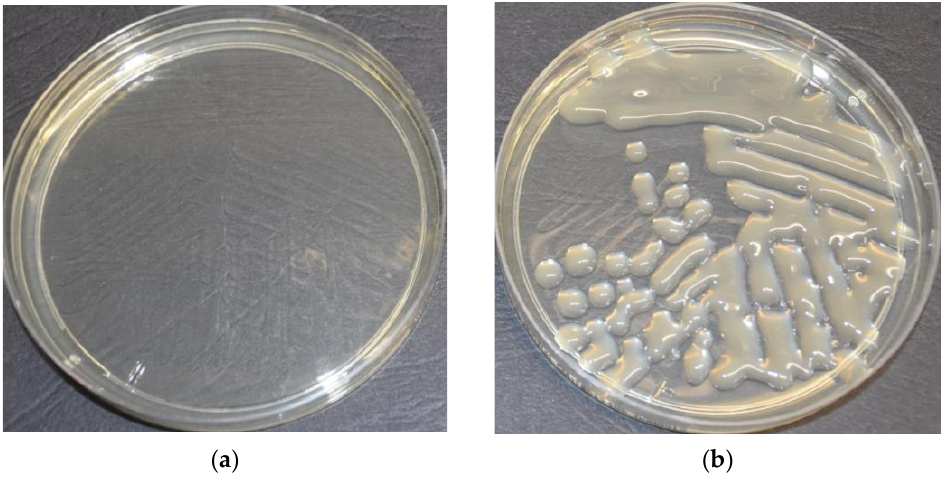
Figure 3. The unusual growth characteristics of Streptococcus equinus MDC1, observed only on mutans selective agar. ( a ) An absence of bacterial growth when incubated at 37 °C aerobically; ( b ) The appearance of mucoid colonies when incubated at 37 °C under anaerobic conditions.